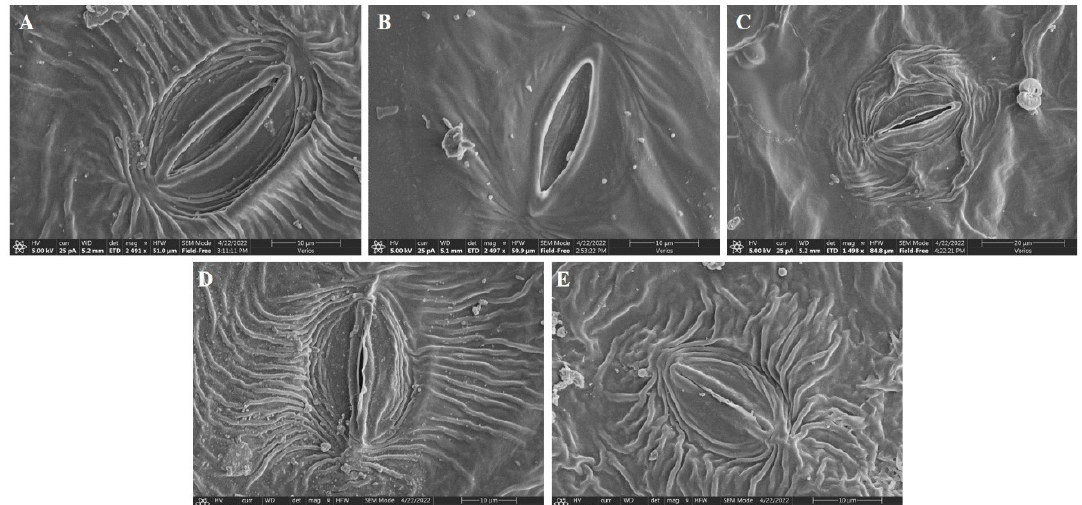
Figure 9. Effect of different V treatments on the stomatal traits of sweet potato leaf. ( A ) Ck, ( B ) 10 L − 1 , ( C ) 25 mg L − 1 , ( D ) 50 mg L − 1 , and ( E ) 75 mg L − 1 Table 4. Effect of different V treatments on the stomatal traits of sweet potato leaf. Vanadium